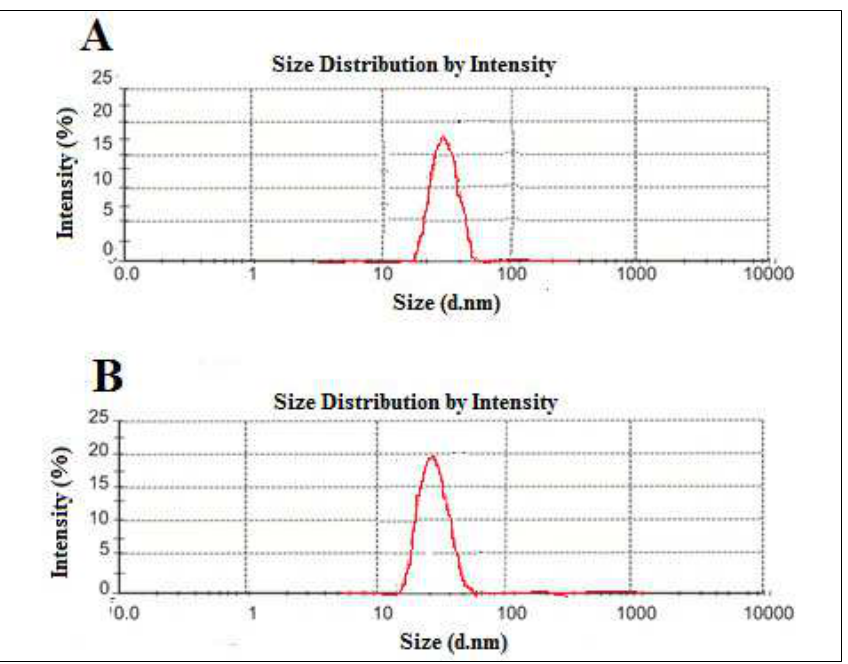
Figure 7. Particle size analysis: ( A ) tamoxifen citrate loaded nanolipid vesicles, ( B ) antibody conjugated tamoxifen citrate loaded nanolipid vesicles,.